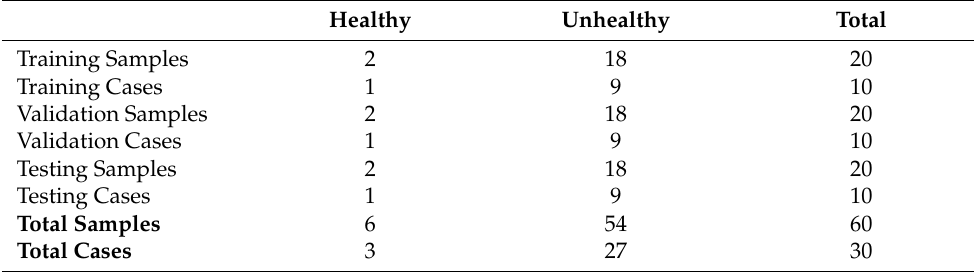
Table 2. Dataset statistics with the class